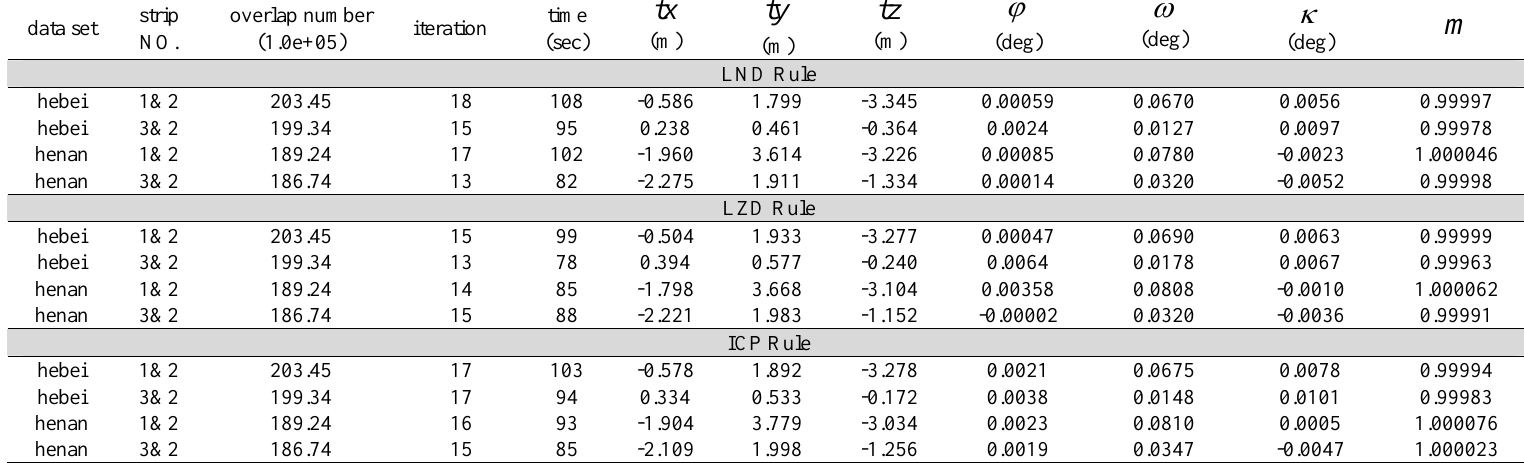
Table 2. Estimated results of unknown parameters between conjugate surfaces. (Iteration number and calculation times are listed in Table 2, and the time and iteration number are similar for three rules because of using same adjustment model. )